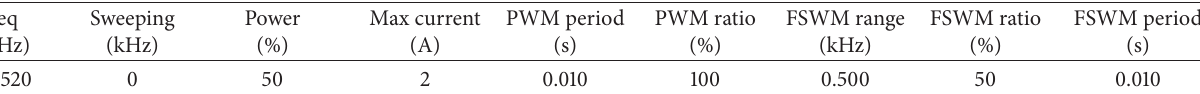
Table 1: Condition process for clamp-on tubular reactor.